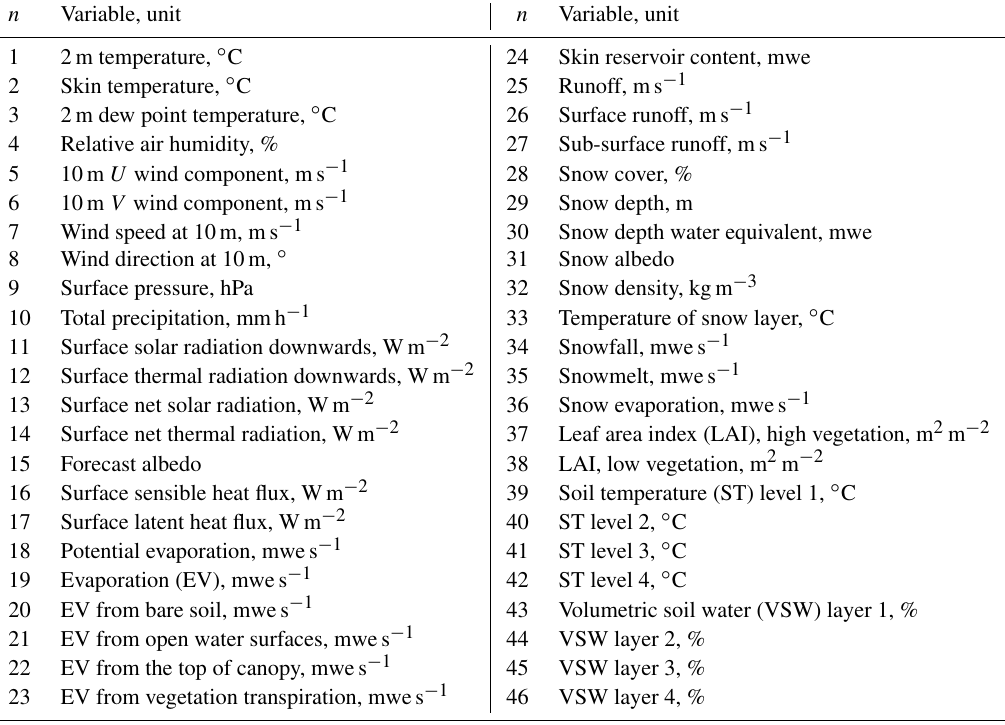
Table 2. List of meteorological variables from ERA5-Land reanalysis used for gap-filling and minimal, maximal, and average values for 2010–2019. mwe: meter of water equivalent.